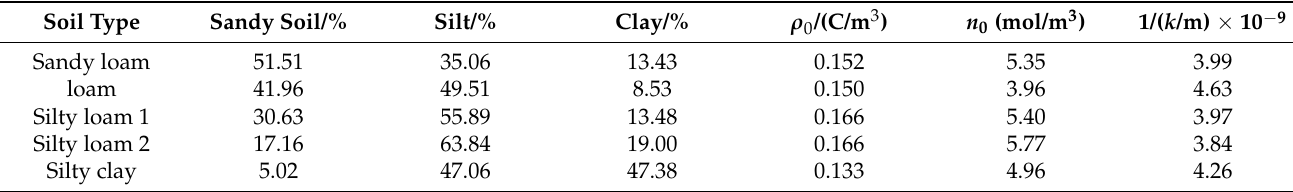
Table 2. The measured data of five soil